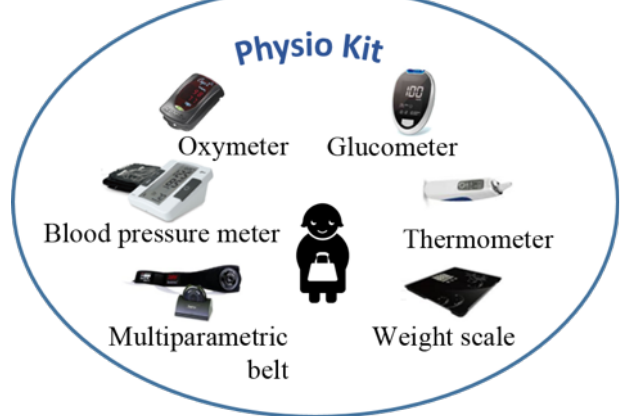
Figure 2. Physio Kit for the measurement of user’s health